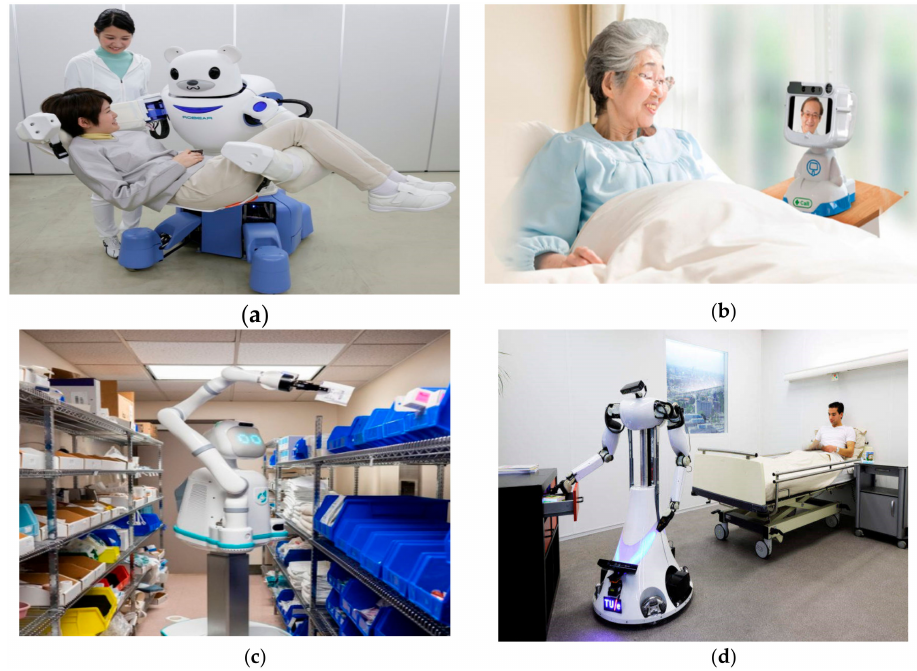
Figure 5. Nursing robots in hospital and at home for elderly care. ( a ) Robear—a robotic bear nurse